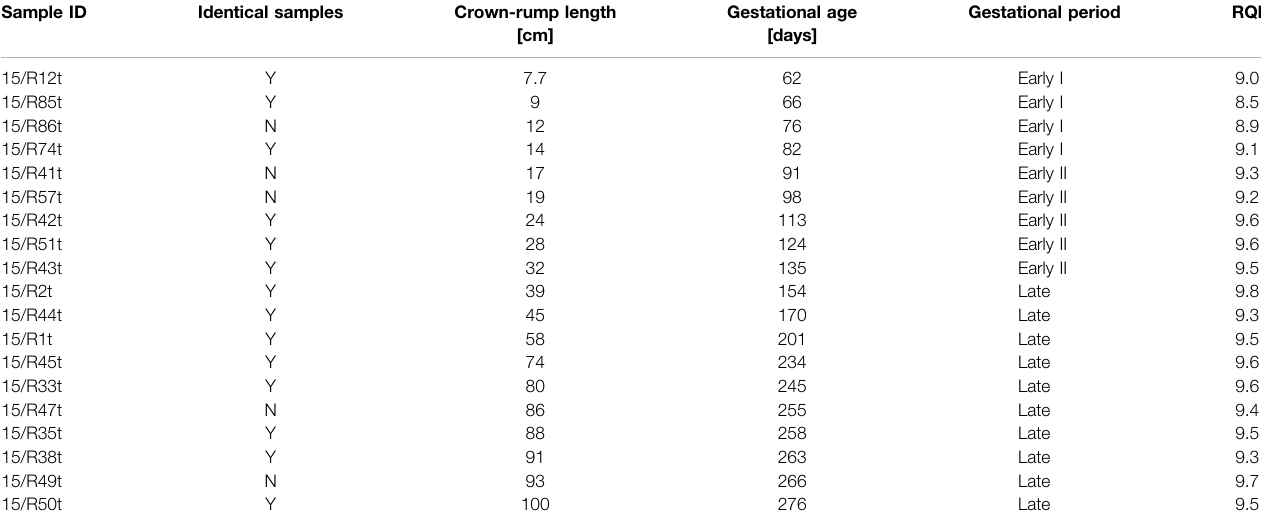
TABLE 2 | Characteristics of bovine fetal ovaries and RNA quality index (RQI). Sample